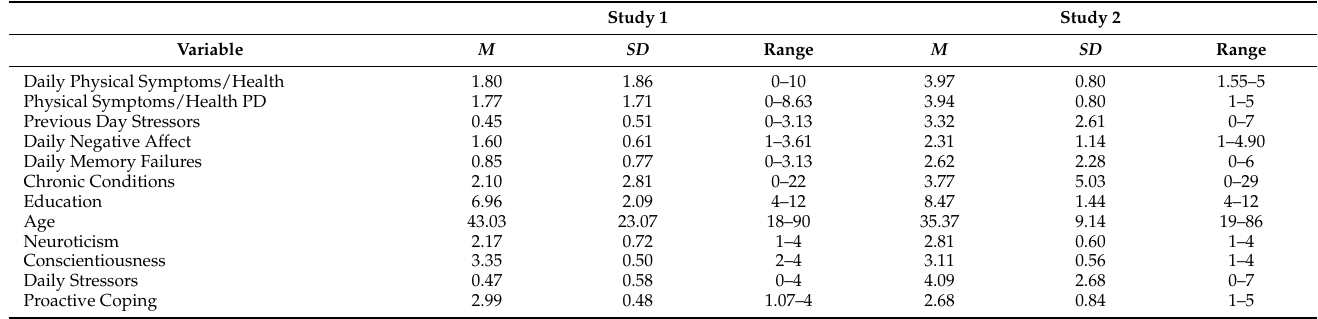
Table 1. Descriptive Statistics for Study Variables.